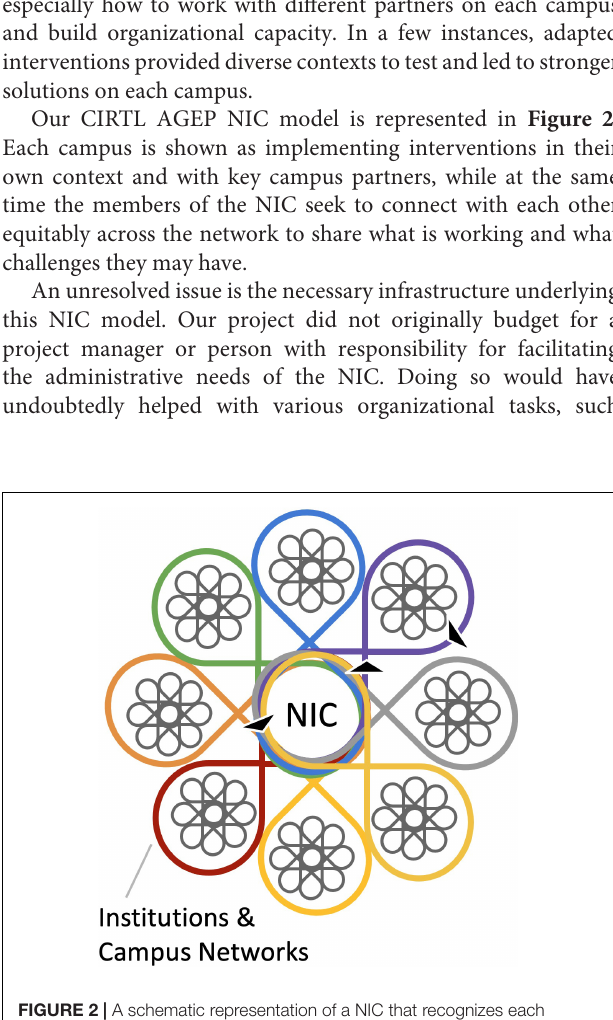
FIGURE 2 | A schematic representation of a NIC that recognizes each campus’ context, shares possible solutions and ideas for infrastructure, and hence accelerates change on each campus. The colors represent different NIC institutions. The arrows represent the information flow between institutional members and the NIC, and from the NIC to institutional